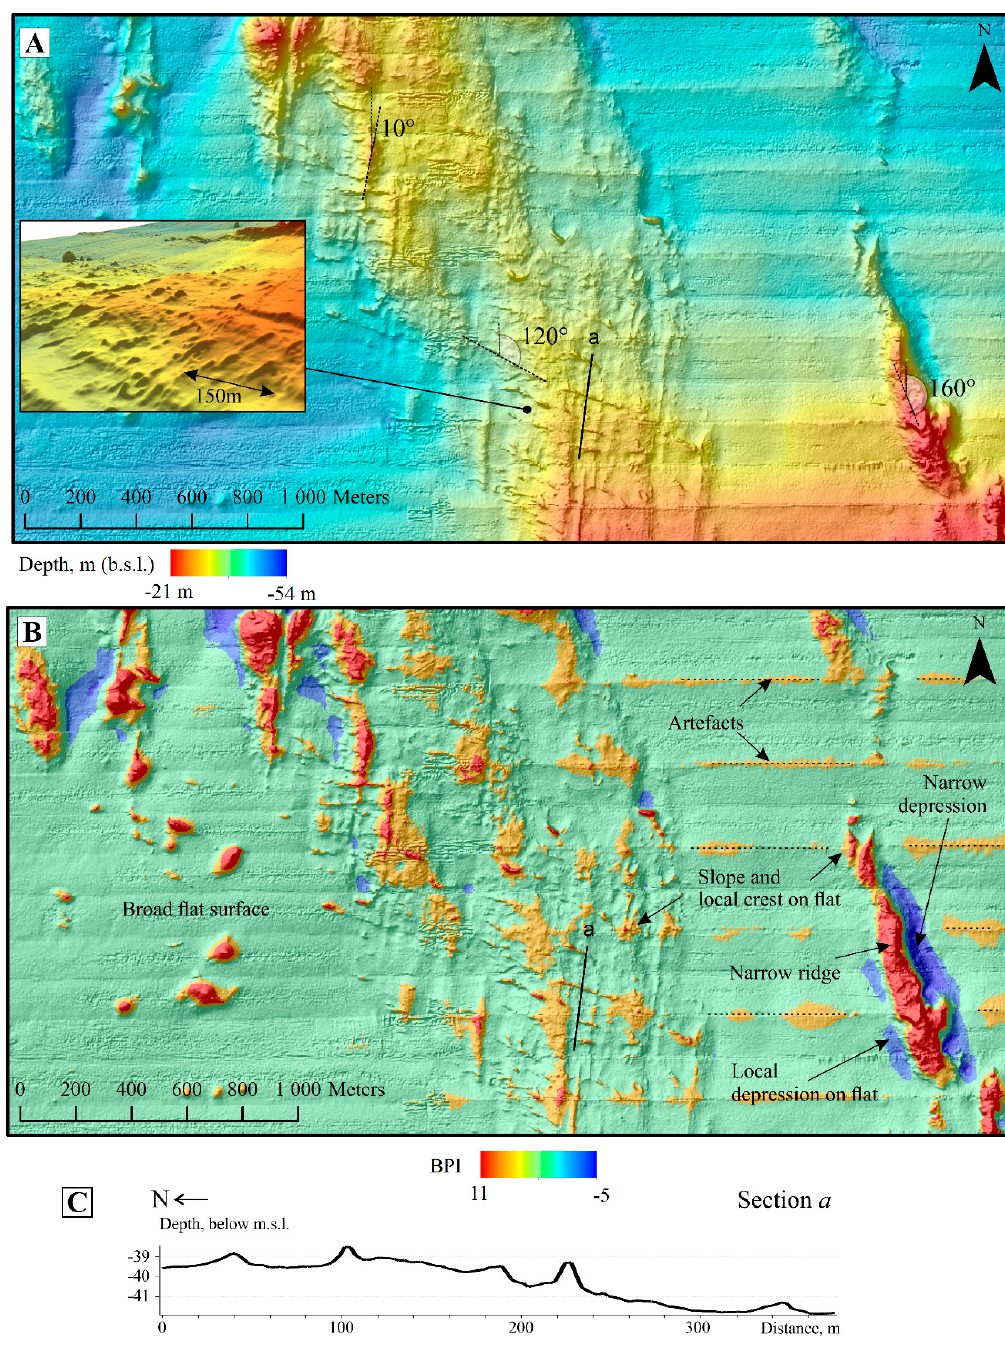
Figure 4. Digital bathymetric model (DBM) of the Moschny Island key area; ( A ) MBES image; ( B ) BPI map; ( C ) N–S oriented bathymetric profile constructed across small ridges.